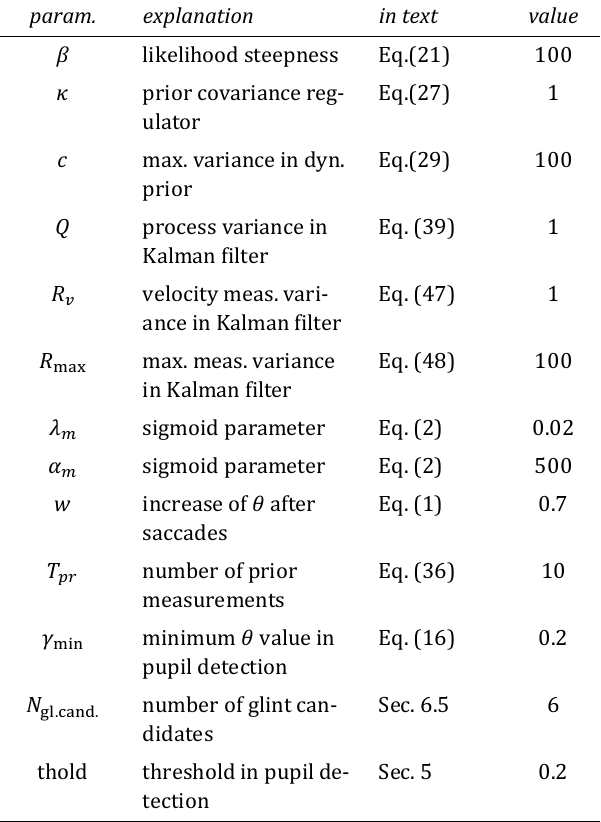
Table 2. The parameters of the model, their explanation, the corresponding equation or section in the text, and the values used.